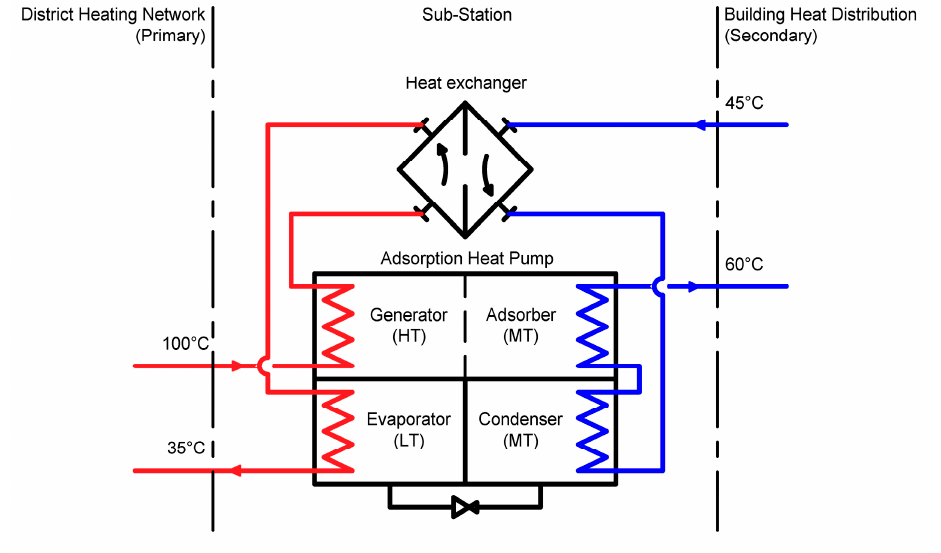
Figure 5. District heating substation including adHP, according to [26].